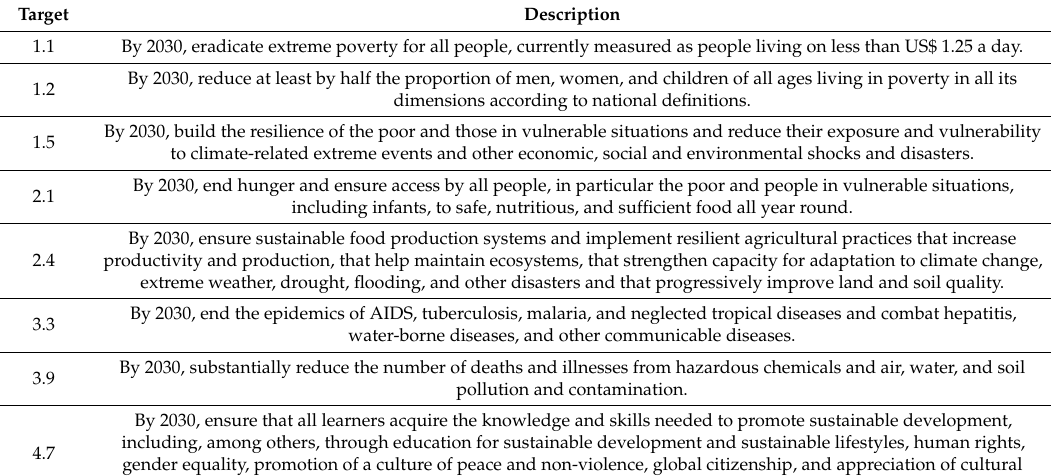
Table 2. The 33 Sustainable Development Targets selected as most relevant to